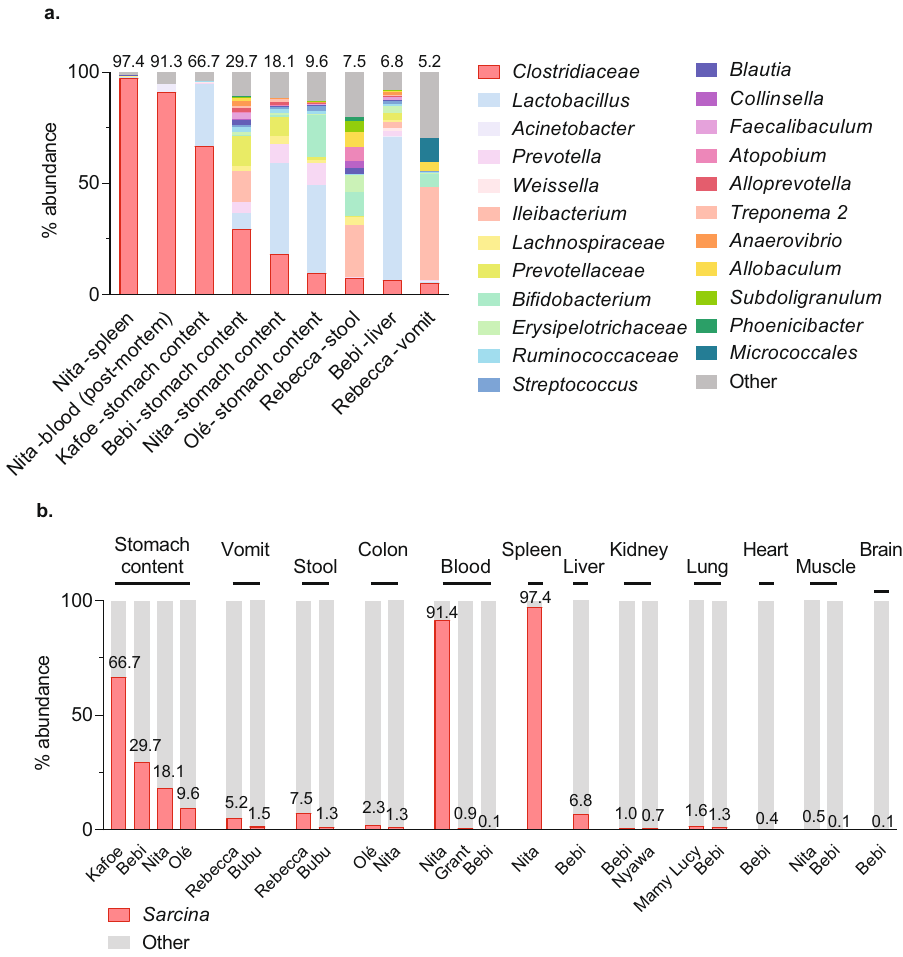
Fig. 4 Bacterial 16S rDNA microbiome analysis of epizootic neurologic and gastroenteric syndrome (ENGS) case samples. a The percentage of total reads ( n = 5900 per sample) from 9 ENGS case samples at genus-level OTU with % reads mapped to the Clostridiacea OTU shown on top of each bar. b Percent abundance of reads from 23 ENGS case samples classi fi ed to genus-level OTUs Sarcina (% above each bar) and other, arranged by tissue